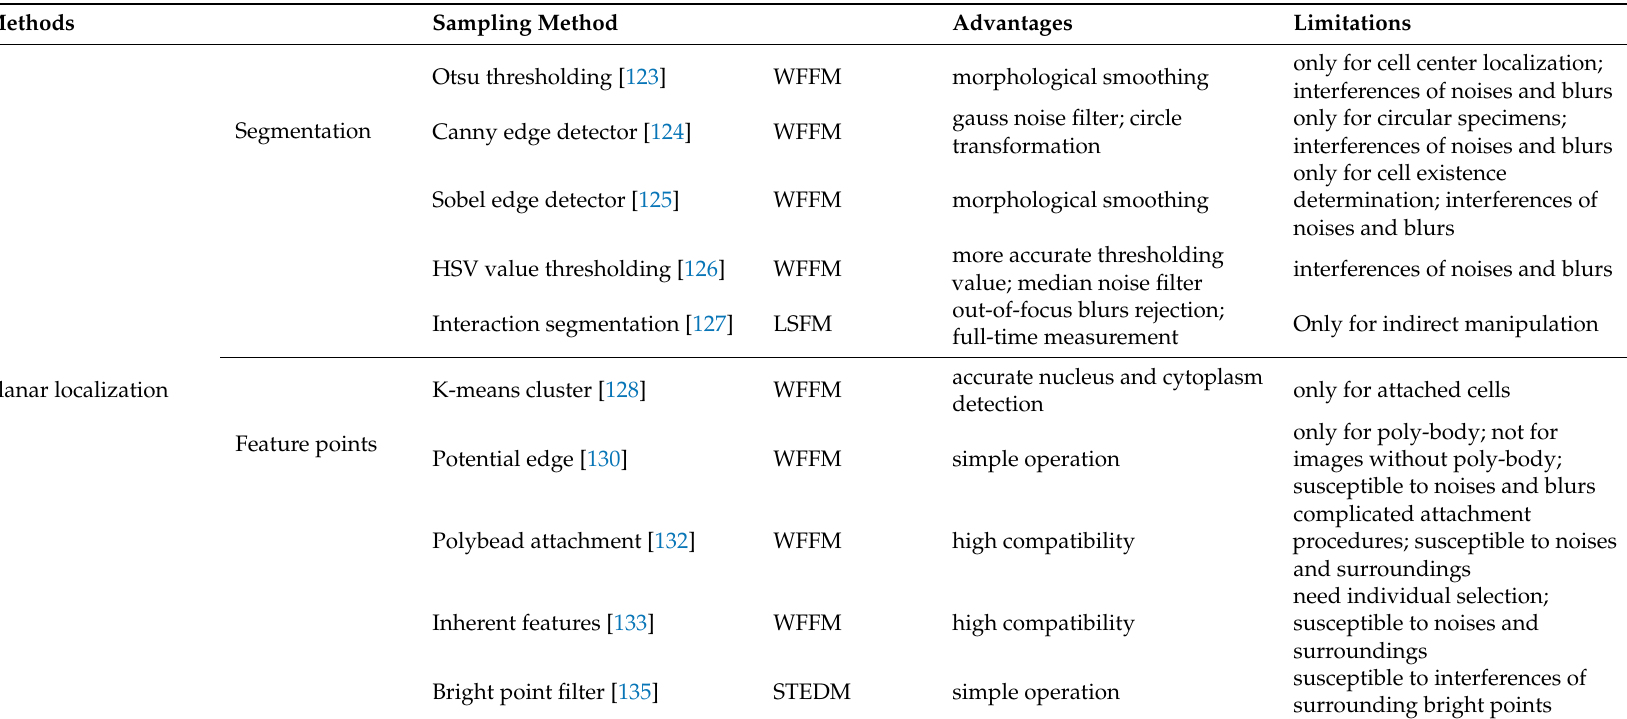
Table 2. Comparison of various image computational processing methods for intracellular